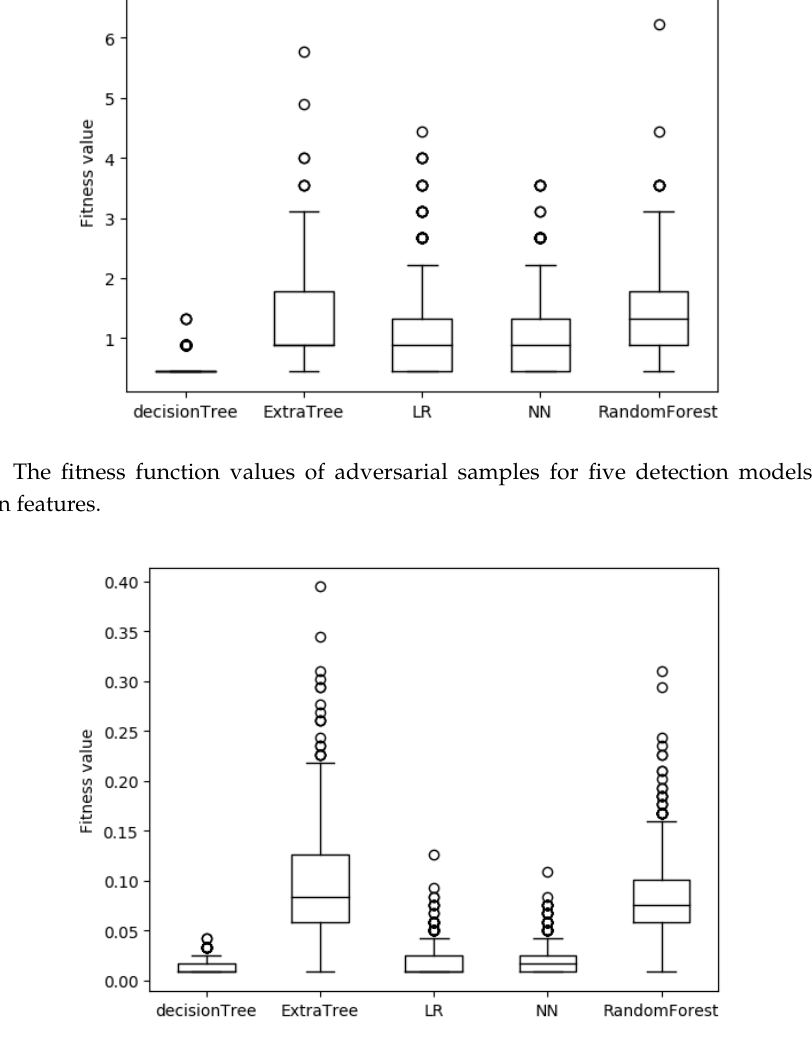
Figure 6. The fitness function values of adversarial samples for five detection models with S2 permission